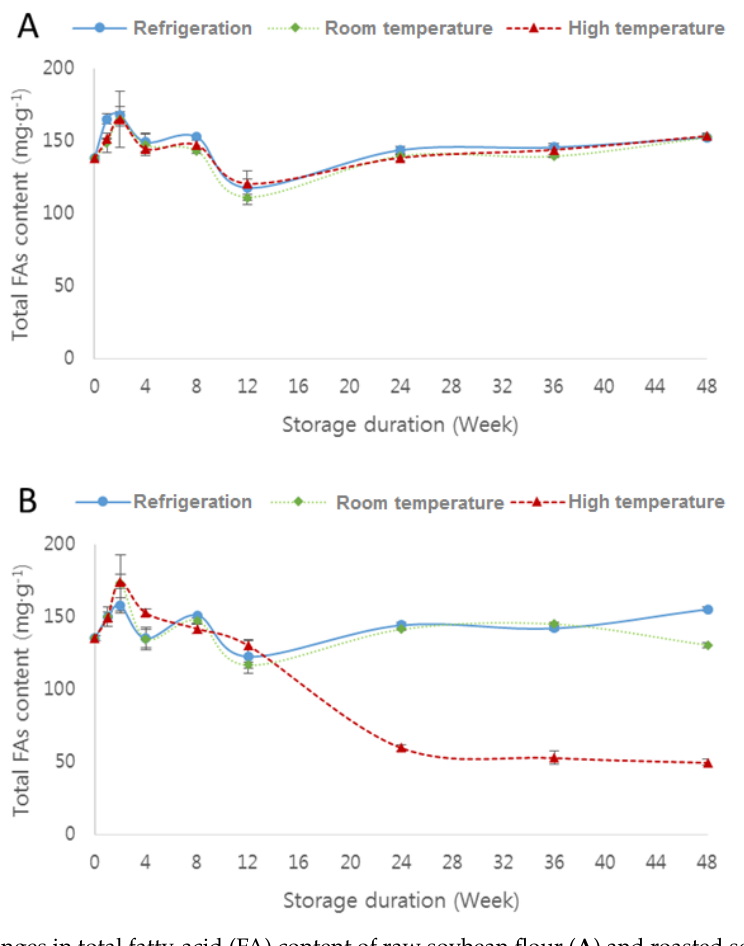
Figure 2. Changes in total fatty-acid (FA) content of raw soybean flour ( A ) and roasted soybean flour ( B ) packed in polypropylene film under different storage temperature conditions: refrigeration (4 °C), room temperature (20 °C), and high temperature (45 °C).